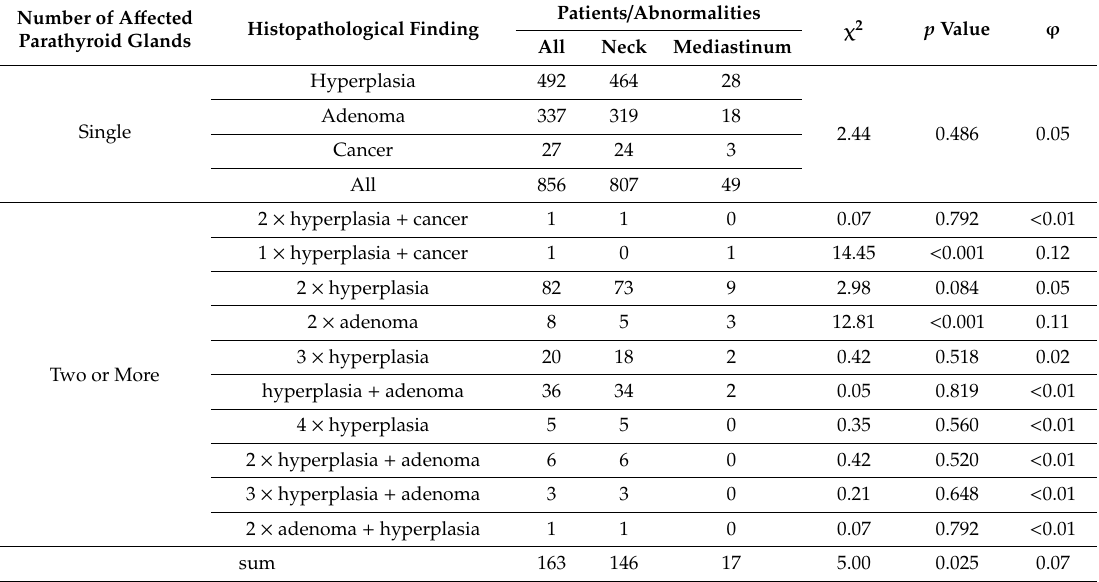
Table 3. Histopathological